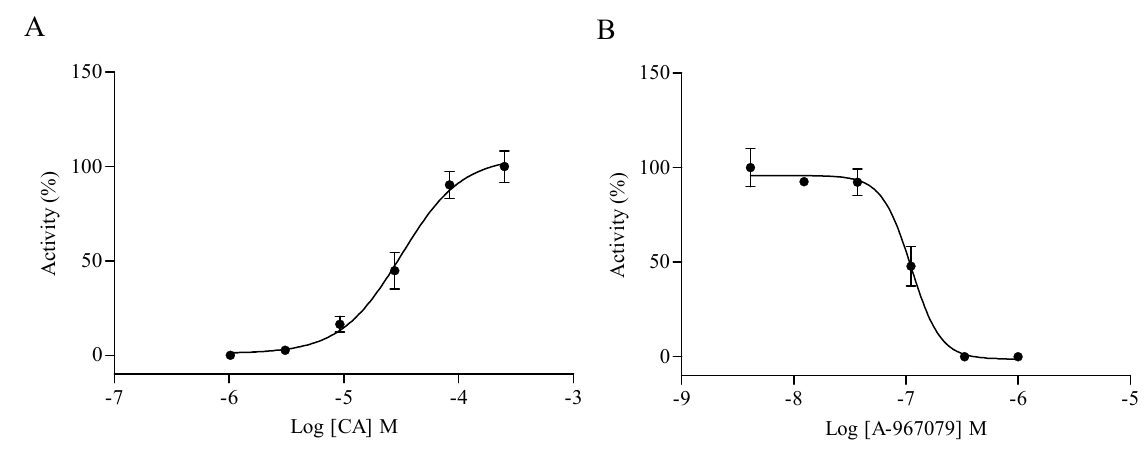
Figure 1. HEK293/transient receptor potential ankyrin 1 (TRPA1) cell line validation. ( A ) Concentration-response curves of cinnamaldehyde (CA). The EC 50 value of CA was 31.54 µM; ( B ) Concentration-response curves of A-967079 (evoked by 90 µM CA). The IC 50 value of A-967079 was 0.11